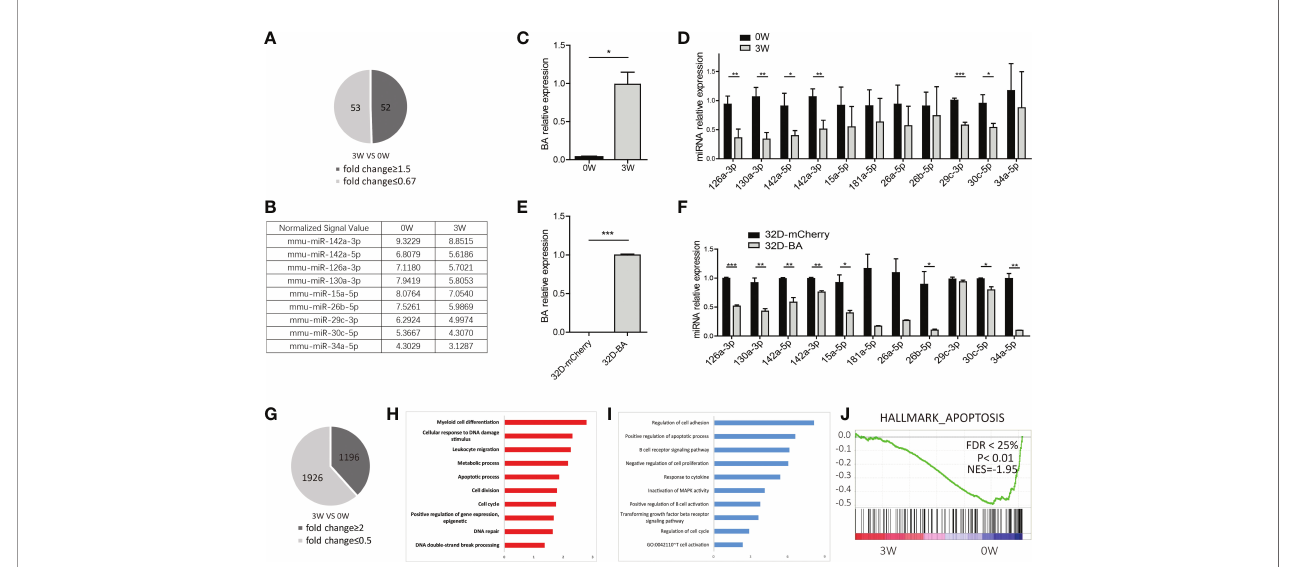
FIGURE 2 | miRNA and mRNA alteration of BM LSKsin Scl/tTA-BA mice. (A) Number of dysregulated miRNAs detected by miRNA array (fold-change ≥ 1.5 or ≤ 0.67). (B) Normalized signalvalues of representative differentially expressed miRNAs. (C) Expression detection of BA in BMLSKsofScl/tTA-BA mice. (D) qRT-PCR con fi rmation of expression level ofselected miRNAs in BM LSKs from Scl/tTA-BA mice. (E) Expression detection of BA in32D-BA cellline. (F) qRT-PCR con fi rmation of expression level of selected miRNAs in 32D-BA cellline. (G) The number of dysregulated genes detected by RNA-seq (fold-change ≥ 2 or ≤ 0.5). (H, I) GO analysis of differentially expressed genes between BA-harboringandnormal BMLSKs. (J) GSEA showing that theapoptosis pathway was remarkably downregulated inBMLSKsat week-3 after doxycycline withdrawal. Results are mean ± SEM, *p < 0.05, **p < 0.01, ***p < 0.001 (C – F) was assessedby unpaired t